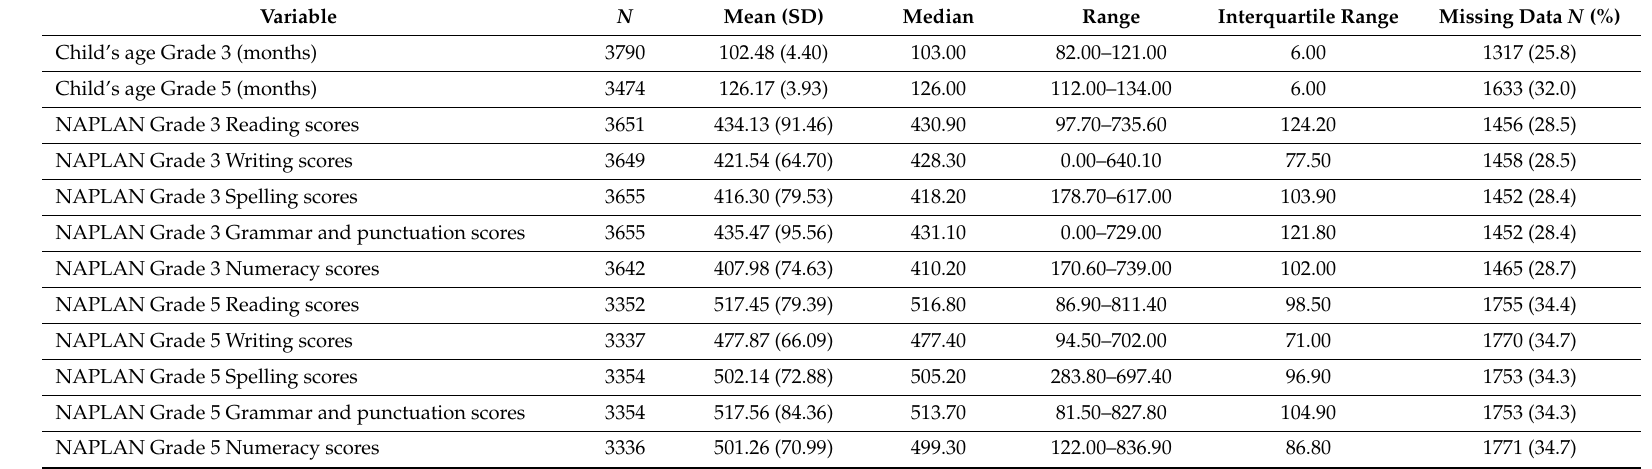
Table 2. Descriptive statistics for child’s age and NAPAN scores prior to